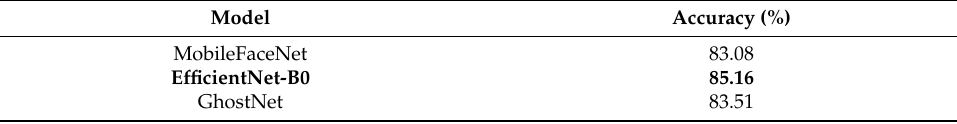
Table 5. Verification performance with the CPLFW [13]